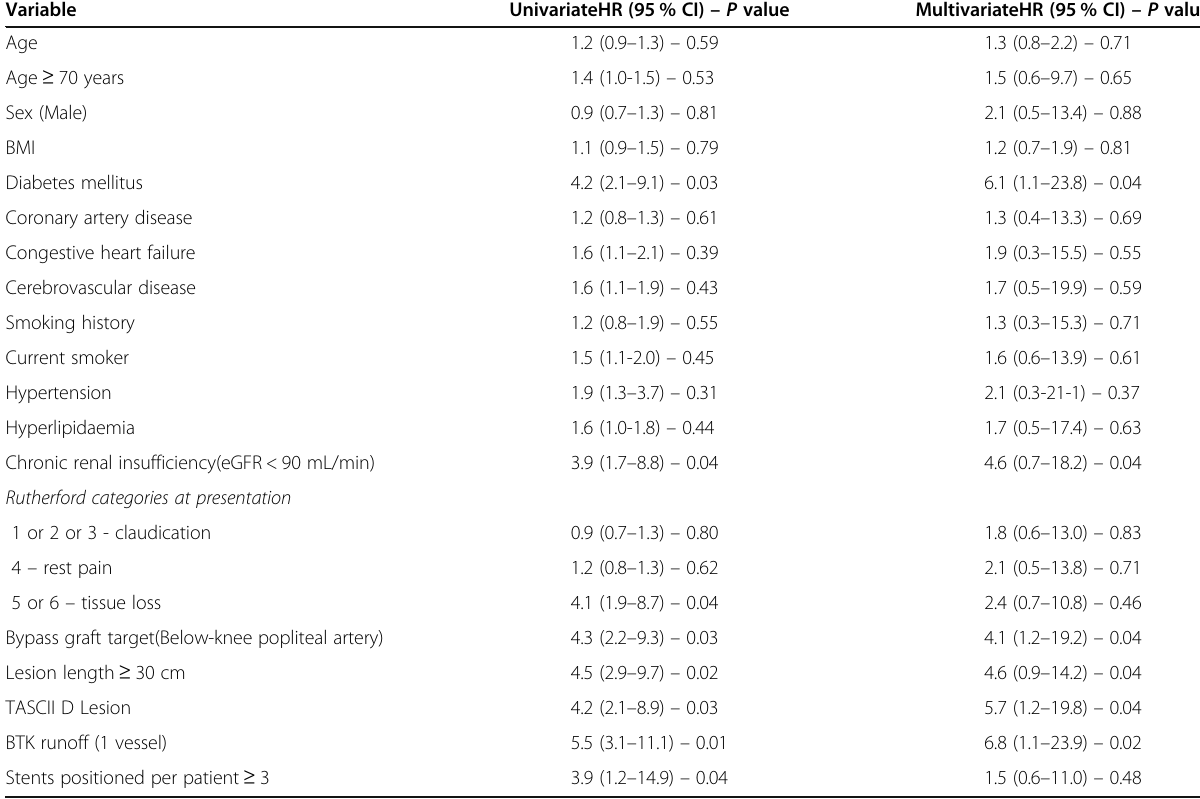
Table 3 Predictors of primary patency loss by Cox proportional hazards regression